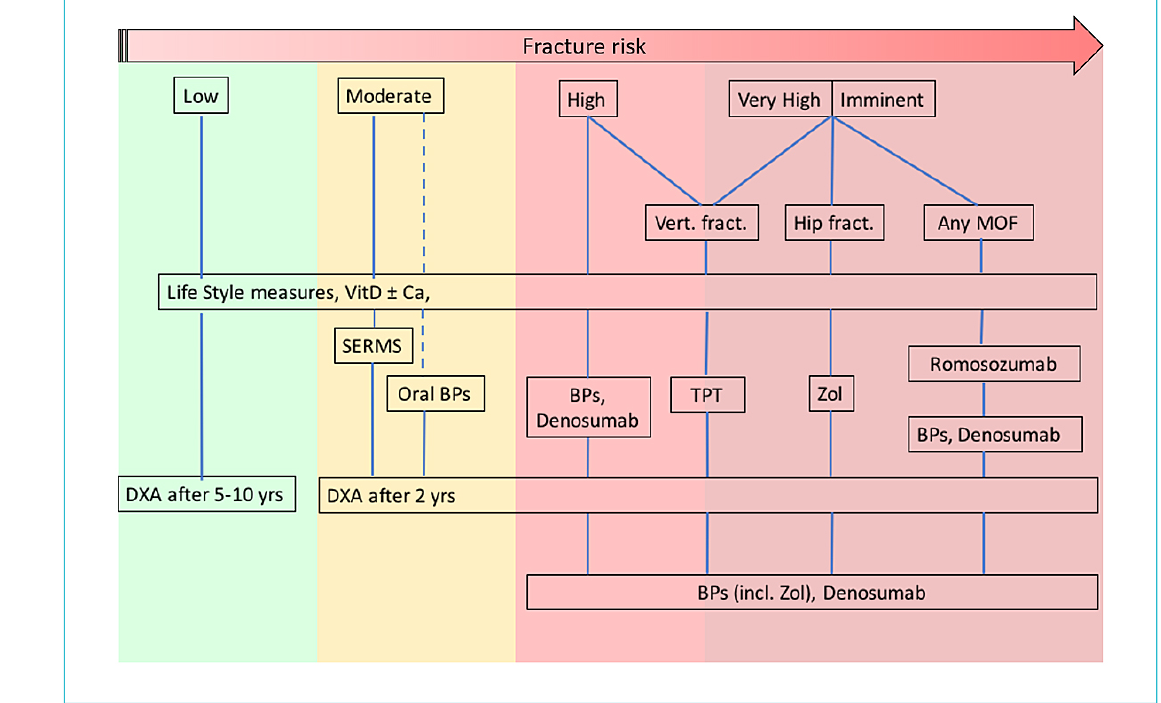
Figure 2: Treatment recommendations by level of risk. SERMS = selective oestrogen receptor modulators; BPs = bisphosphonates; Zol = zoledronate; TPT = teriparatide. Dashed lines indicate alternative treatments (see text for